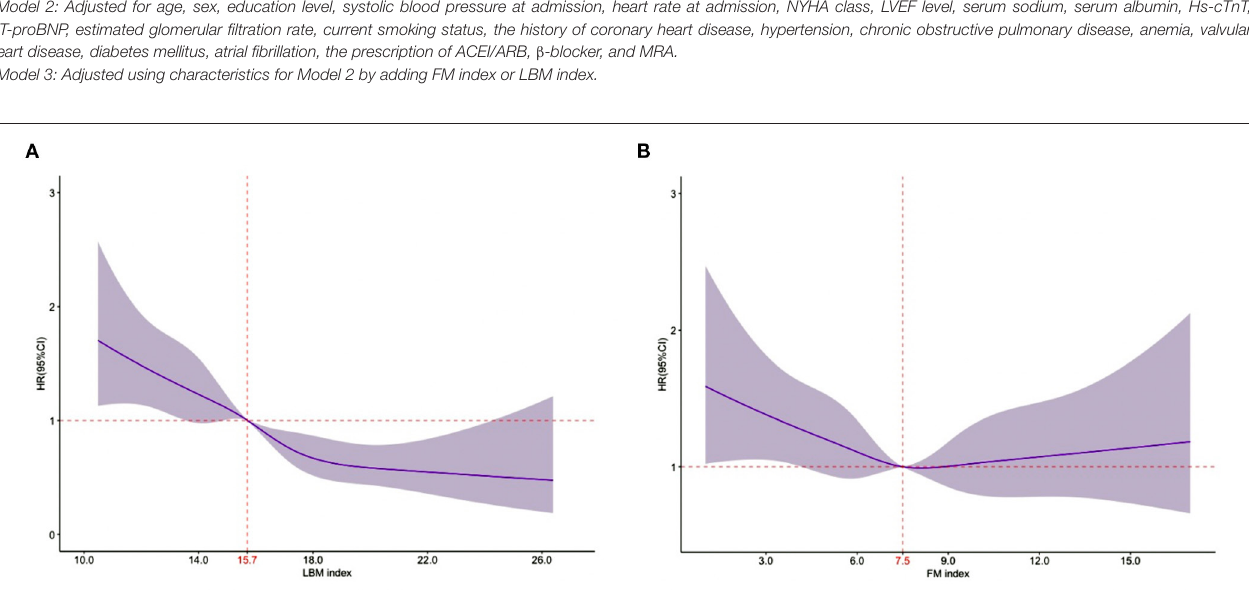
FIGURE 2 | Relationship of the LBM index and the FM index with 1-year all-cause mortality using restricted cubic splines. (A) . Relationship between LBM index and 1-year all-cause mortality [the reference point was 15.7 (median); P -overall association < 0.01; P -non-linearity = 0.52]. (B) . Relationship between FM index and 1-year all-cause mortality [the reference point was 7.5 (median); P -overall association = 0.19; P -non-linearity = 0.22]. (A,B) represent the results of multivariate analyses adjusted for age, sex, education level, systolic blood pressure at admission, heart rate at admission, NYHA class, LVEF level, serum sodium, serum albumin,